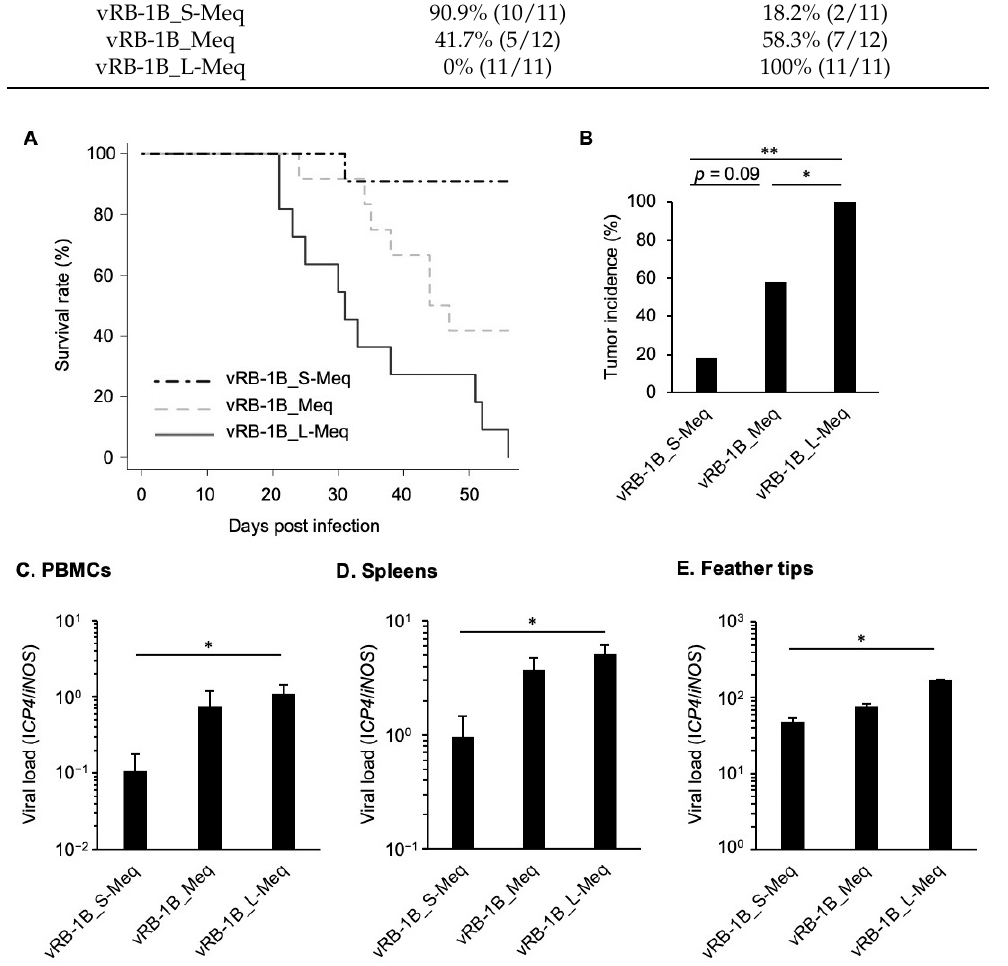
Figure 5. Mortality and tumor incidence in chickens infected with recombinant MDVs. ( A ) Survival rate in chickens infected with recombinant Marek’s disease viruses (rMDVs). Asterisks indicate significant differences. (** p < 0.01, * p < 0.05; log-rank test). ( B ) Tumor incidence in chickens infected with rMDVs throughout the study period. Asterisks indicate significant differences (** p < 0.01, * p < 0.05; Fisher’s exact test). The viral loads in ( C ) peripheral blood mononuclear cells, ( D ) spleens, and ( E ) feather tips from chickens infected with the rMDVs were determined by quantitative polymerase chain reaction. Asterisks indicate significant differences (** p < 0.01; Kruskal–Wallis test).